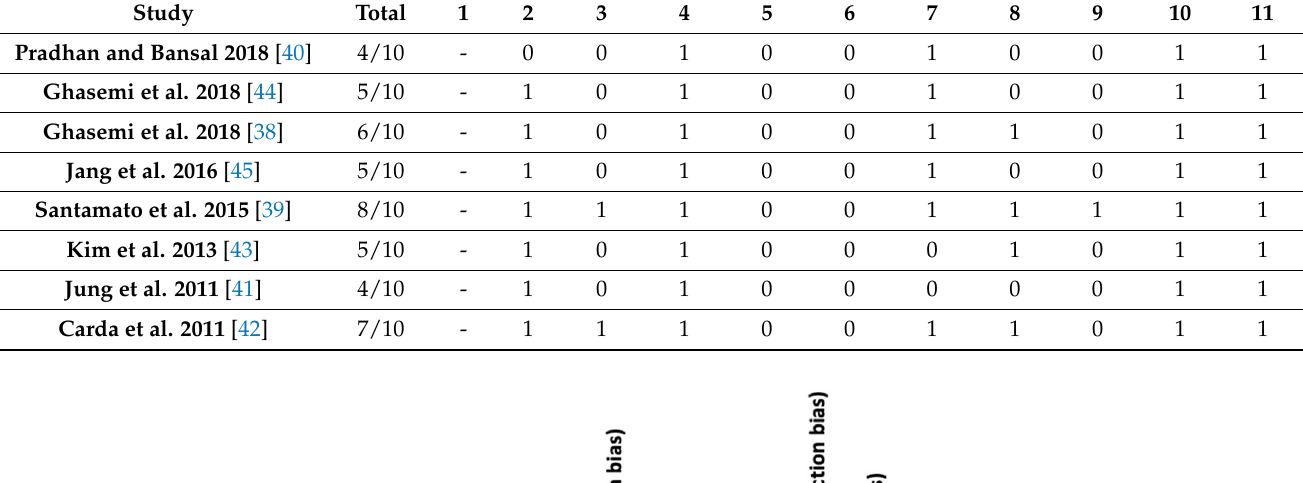
Table 2. Score obtained on the PEDro scale for each of the selected studies.